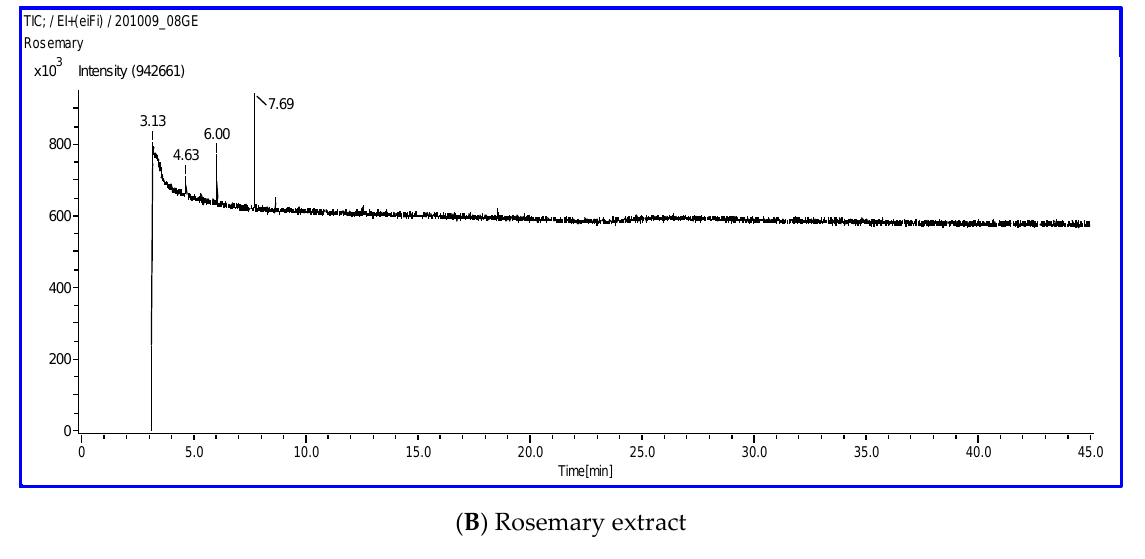
Figure 1. GC-MS chromatogram of ethanolic clove ( A ) and rosemary ( B ) extracts. Table 2. The main chemical compositions of ethanolic plant extracts used in this study. The main chemical components in clove extract were found to be eugenol (63.73%), caryophyllene (13.97%), and phenol, 2-methoxy-4-(2-propenyl)-, acetate (12.72%), while glycidol (67.98%), 1-isopropyl-4-methylbicyclo [3.1.0] hex-2-ene (4.66%), eucalyptol (6.14%), and camphor (17.15%) were found in rosemary extract (Table 2).